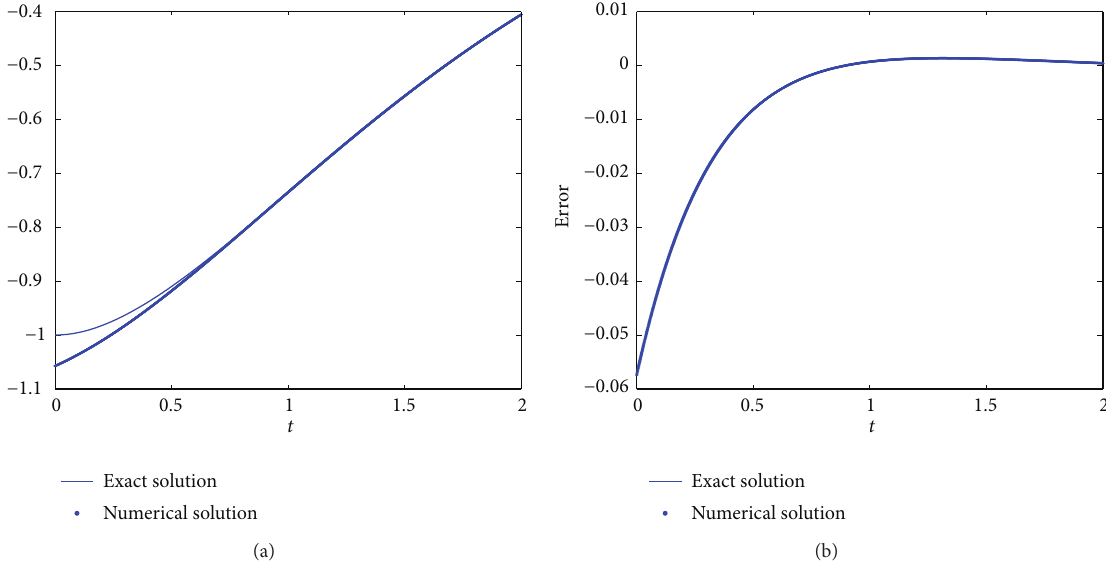
̂ 𝑓(𝑡) ̂ 𝑓(𝑡) (a), the error 𝑓(𝑡) − (b) with Δ𝑥 = 0.5 , Δ𝑡 = 0.001